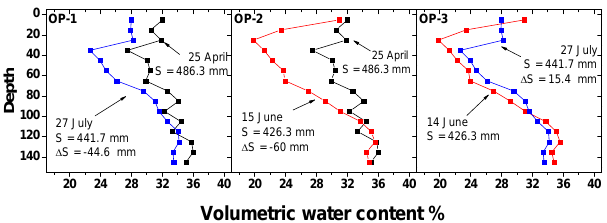
Figure 5. Averaged diurnal cycles of net radiation R n , latent LE, sensible H and ground heat fluxes G in the observation periods (OPs) of 2012 (OP 1–3) and 2013 (OP 4–6).